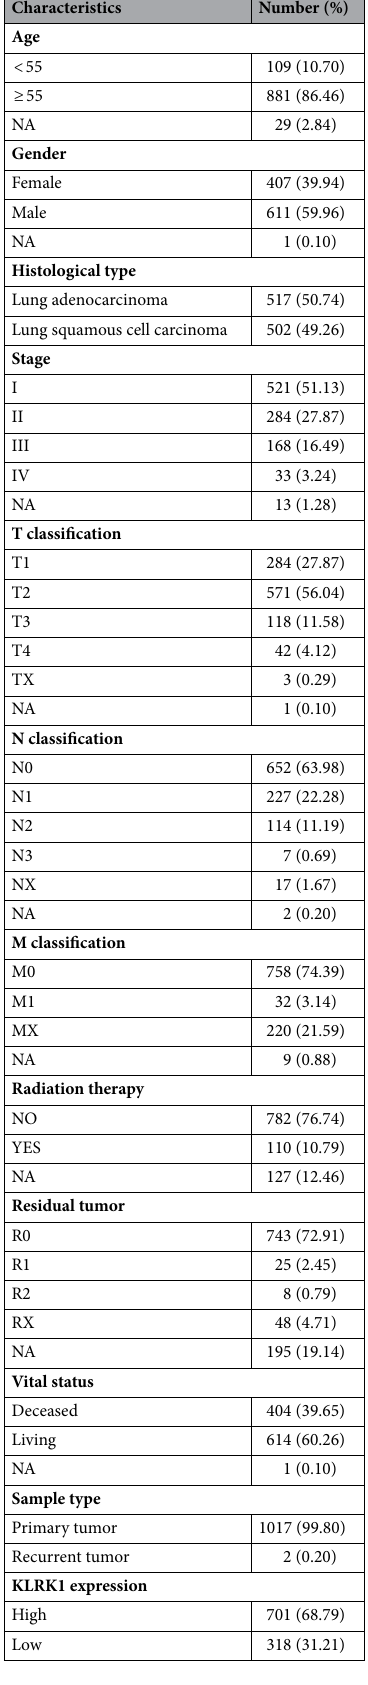
Table 1. Clinical characteristics of the patients with lung cancer. NA not available, X represents